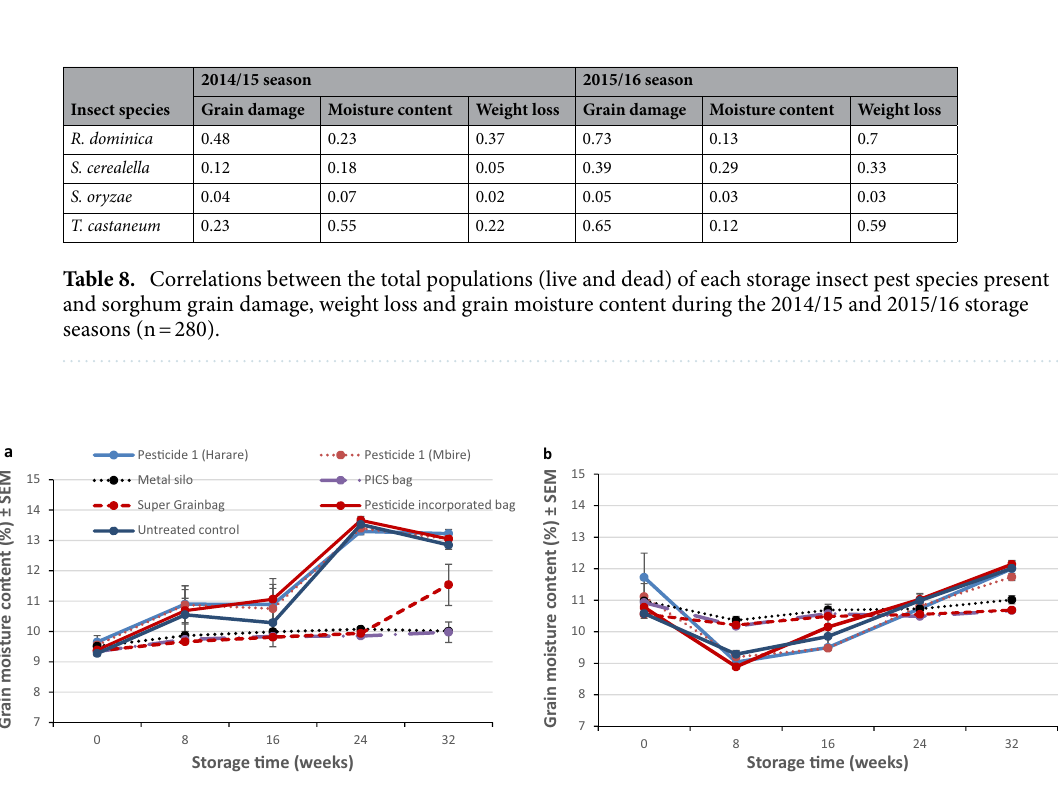
Figure 4. Mean sorghum grain moisture content (% ± SEM) in different storage treatments during: ( a ) the 2014/15 and ( b ) the 2015/16 storage seasons in Mbire district, Zimbabwe (n = 8). Pesticide 1 = fenitrothion 1% + deltamethrin 0.13%; Pesticide 2 = pirimiphos-methyl 0.16% + thiamethoxam 0.036%; Pesticide- incorporated bag = deltamethrin-incorporated polypropylene bag at 3